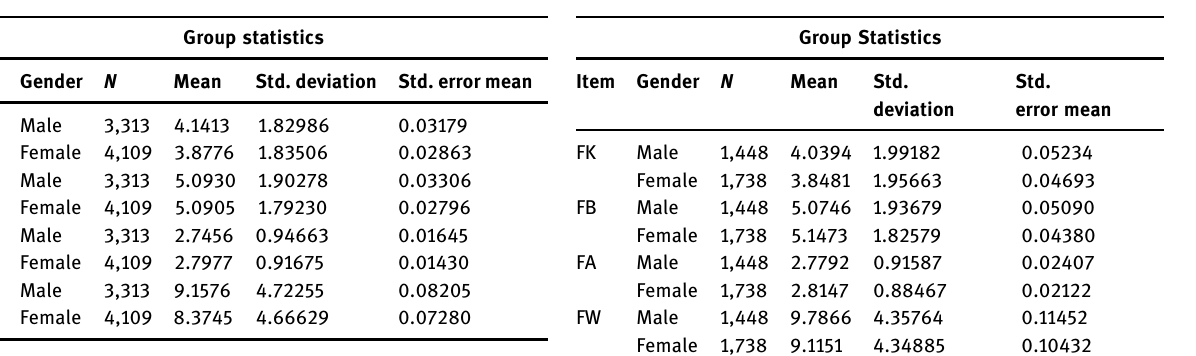
Table 8: Descriptive statistics for items in H1 to H4, regarding gender for EU - 3 countries